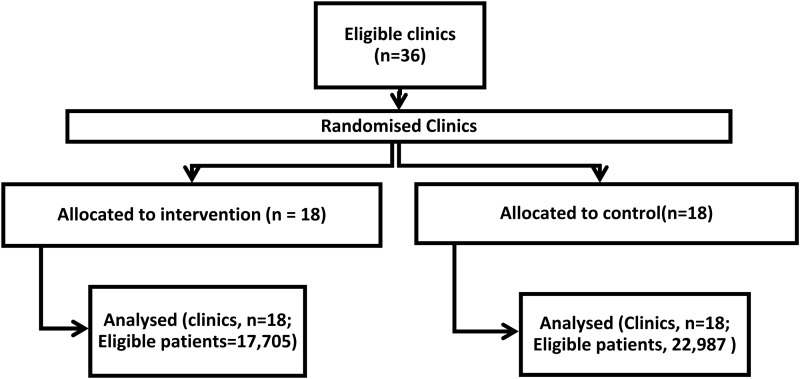
CONSORT flow diagram.